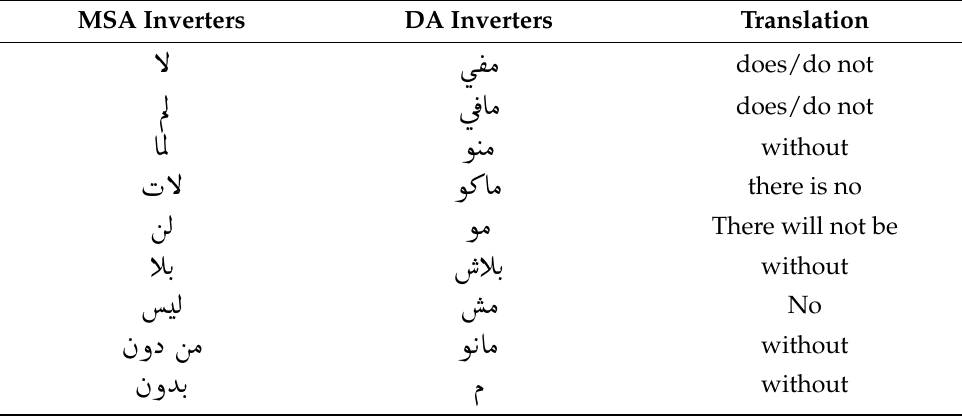
Table 1. Some Arabic Negation Words